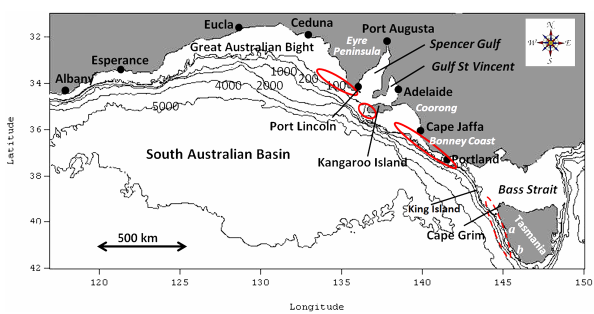
Figure 1. The geography of Australia’s southern shelves. Isobath depths are in metres. Solid-line ellipses display known locations of coastal upwelling centres. The dashed-line ellipse highlights the region investigated in this paper. Letters a and b indicate the loca- tions of the mouths of the Macquarie Harbour estuary and the Davey